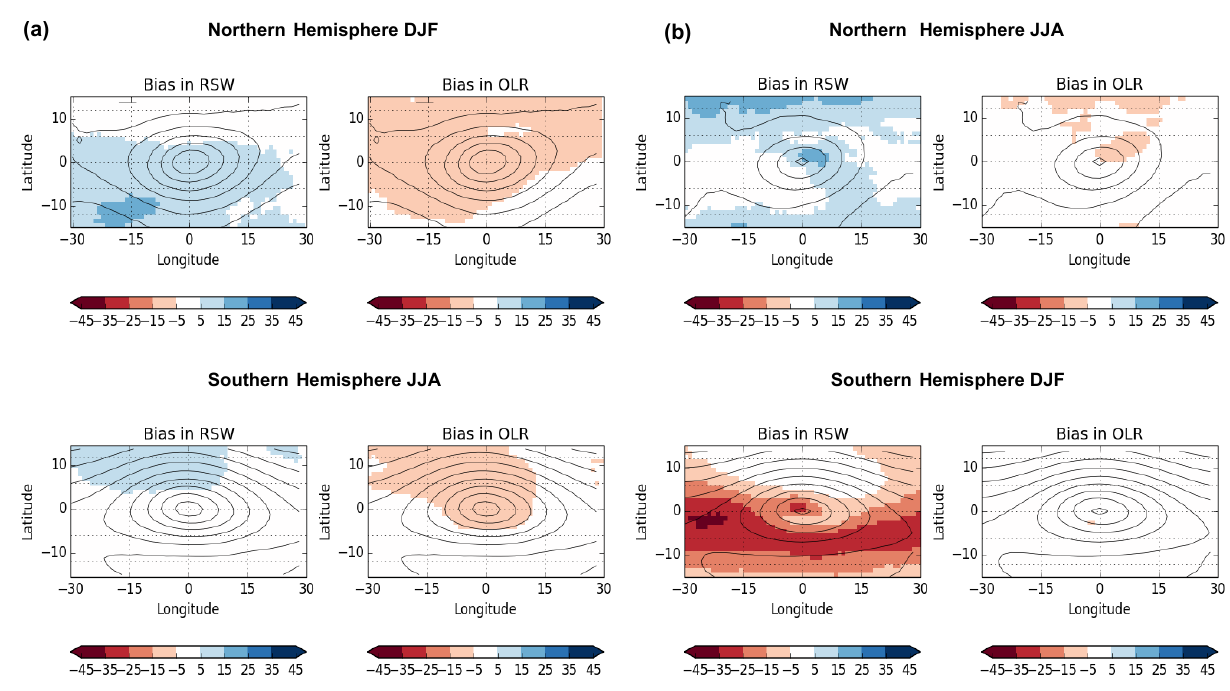
Figure 9. Cyclone composite GA7 mean bias in RSW and OLR (Wm − 2 ) against CERES-EBAF (colours). Black contours are GA7 PMSL. Northern and Southern Hemisphere composites are shown for the respective winter (a) and summer (b) seasons. Student’s t -test based on inter-annual variability shows that errors greater than 5Wm − 2 are statistically significant at the 0.05